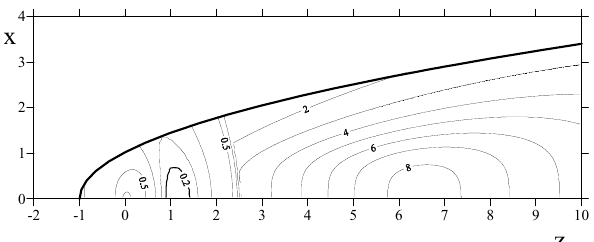
Fig. 5. Isolines of Alfv´en velocity value A (10 3 km/s) distribution used in the model calculations, in the plane ( x,z ). Coordinates x and z are in units of σ – distance from the Earth’s centre to the subsolar point of the magnetopause. The localisation of the NEPS region is 0 . 6 <z< 2 . 5. The region of the Alfv´en velocity maximum in the magnetotail lobes is z ≈ 6 . 5.